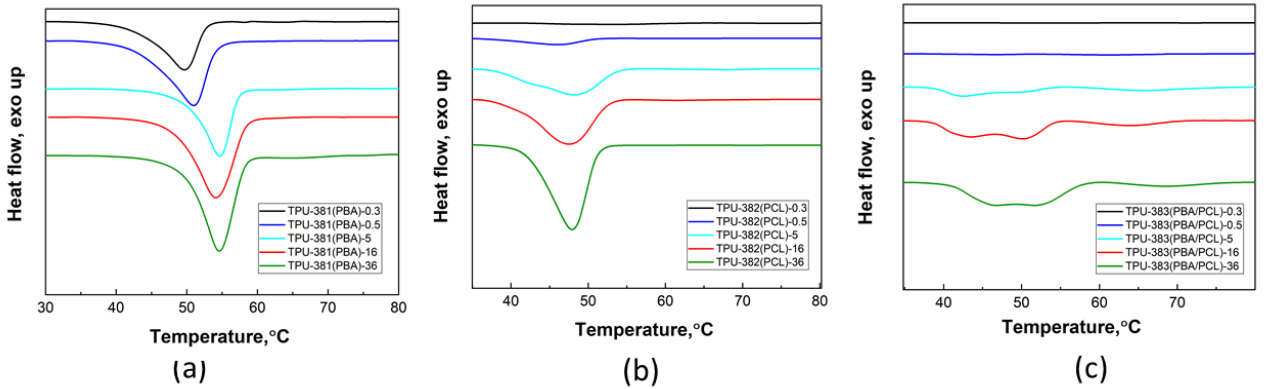
Figure 2. DSC curves for ( a ) TPU-381(PBA), ( b ) TPU-382(PCL) and ( c ) TPU-383(PBA/PCL) given for samples with different storage times in months. Table 2. Thermal parameters for the TPUs determined from the DSC analysis.